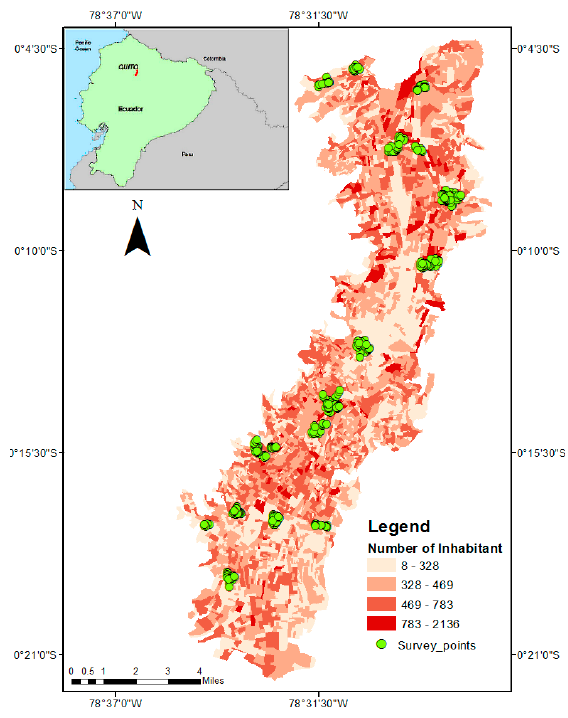
Figure 1. The study area, Quito, Ecuador.